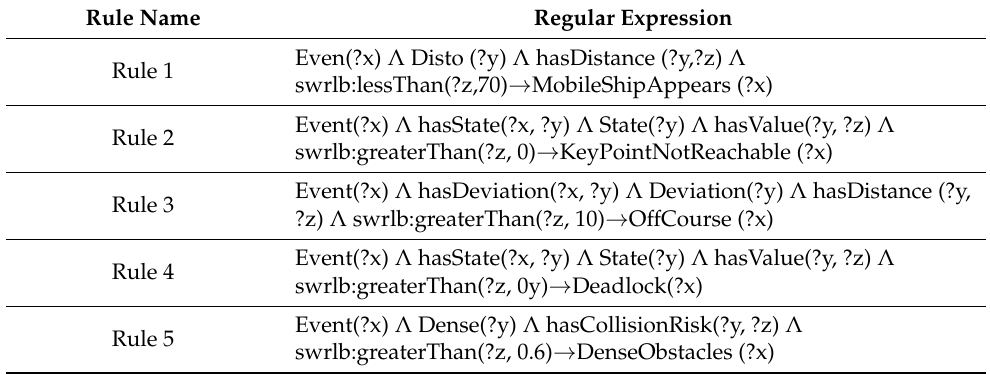
Table 1. Partial SWRL rules for detection of uncertain events of MUSVs.